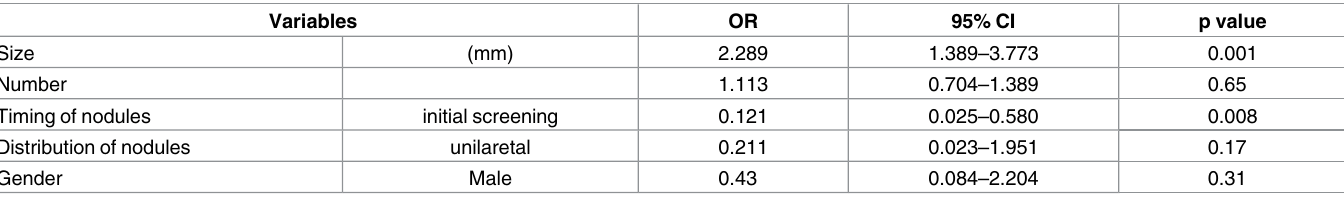
Table 3. Logistic multivariate analysis for diagnosis of pulmonary nodules *